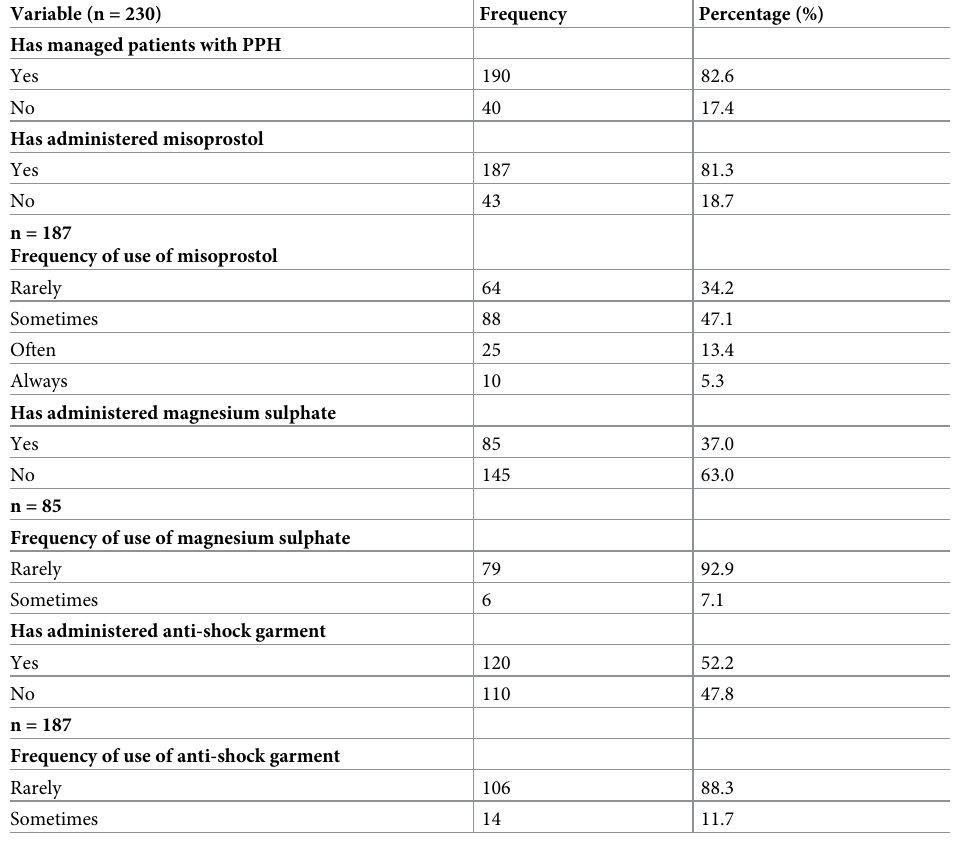
Table 5. Utilization of the technologies among respondents.